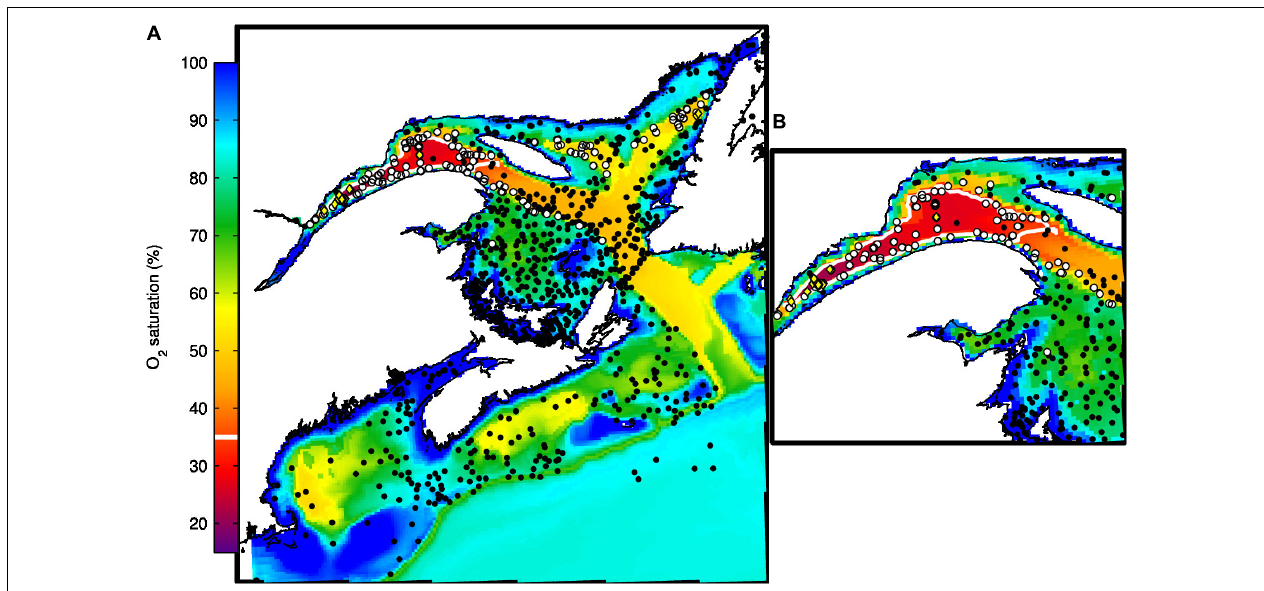
FIGURE 11 | (A) Mean simulated bottom oxygen saturation for June and July of 2009 and 2010. Dots represent position of observations for the same months and years. White dots (observation) and line (simulation) correspond to saturation values smaller than 35%, while yellow diamonds correspond to saturation values smaller than 20%. Panel (B) presents an enlargement of the Lower St. Lawrence Estuary and Northwest Gulf of St. Lawrence regions.